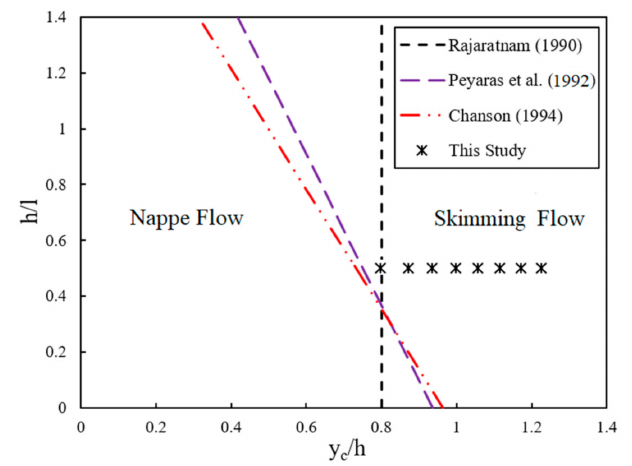
Figure 2. Flow regime boundaries for stepped spillways in the current study.